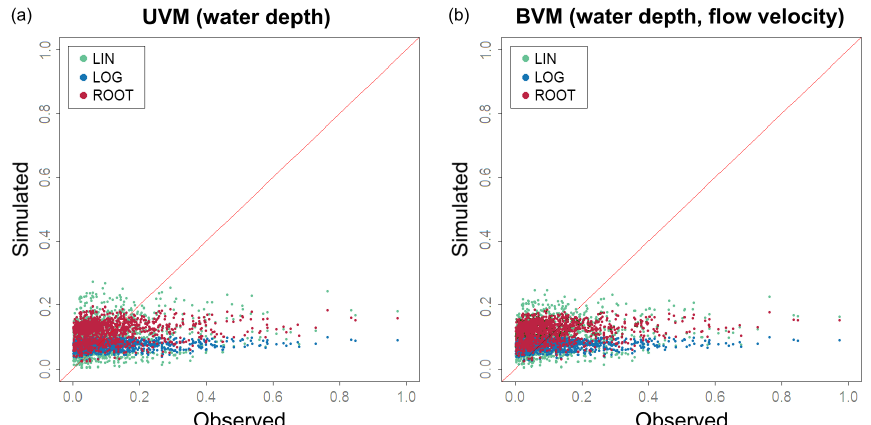
Figure 10. Testing the predictive capacity of uni- and bivariable models: estimated relative damage ( y axis) from the UVM (a) and BVM (b) are plotted against observed relative damage ( x axis), according to the three tested regression functions (LINear, LOGarithmic and ROOT